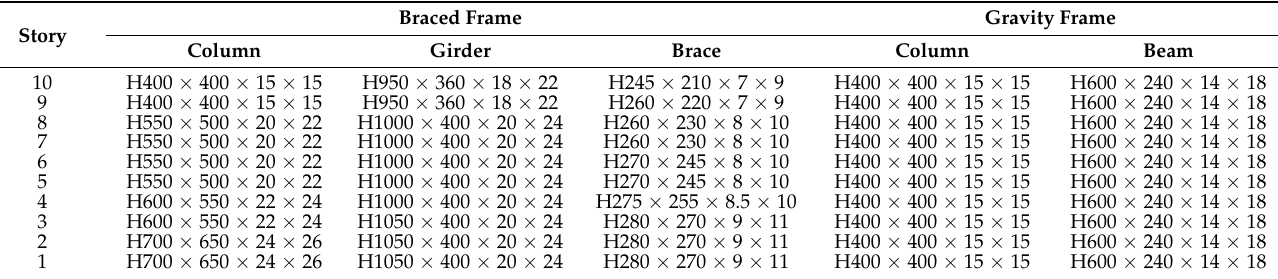
Table 2. Design-member sizes of 10-story prototype (unit: